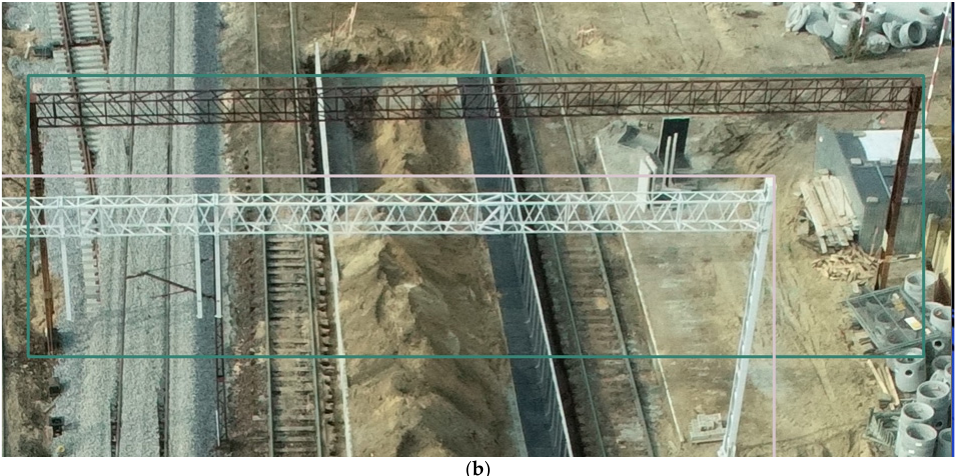
Figure 14. An example of a training dataset for gates with IoU = 0.73; ( a ) the bounding box generated from DIM point clouds; ( b ) ground-truth bounding box from TLS point cloud.